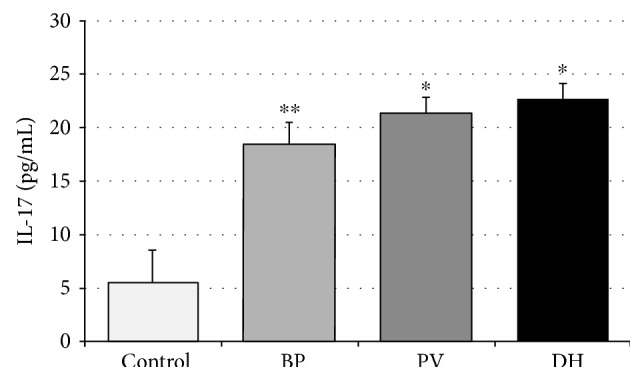
IL-17 expression in patients with bullous pemphigoid (BP), pemphigus vulgaris (PV), and dermatitis herpetiformis (DH). Data represent the mean ± SEM. ∗p < 0.0001 versus that in the control; ∗∗p < 0.001 versus that in the control.